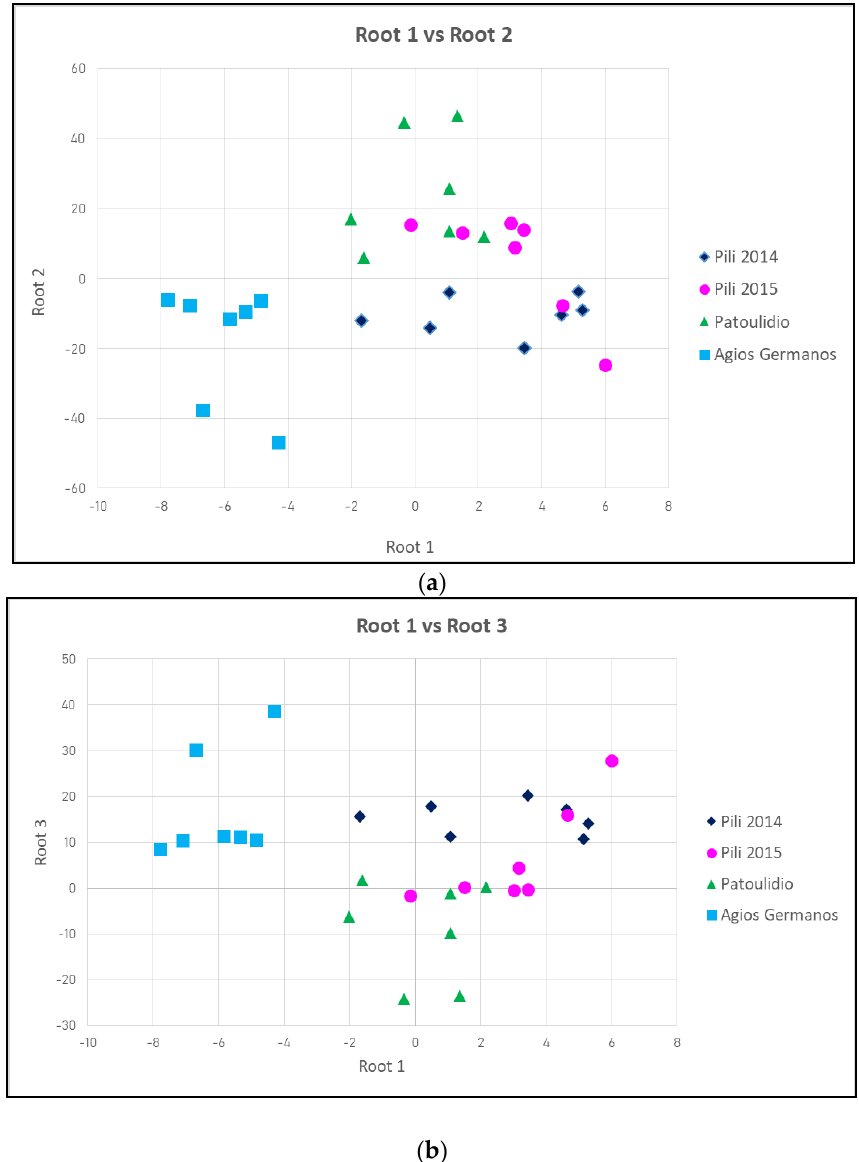
Figure 5. ( a ): Scatter plot of canonical scores for function 1 and function 2 plots. ( b ): Scatterplot of canonical scores for function 1 and function 3 plots.